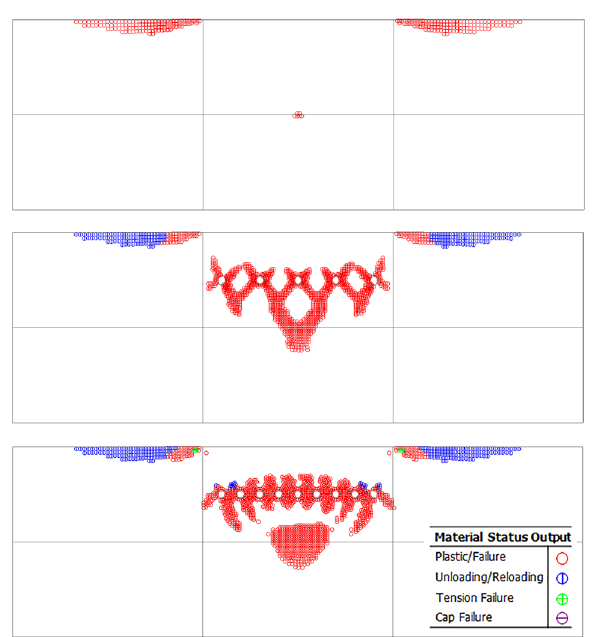
Fig. 11 Plastic zone evolution of the multi-hole